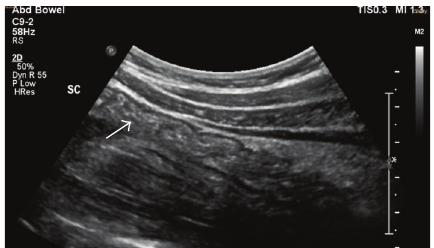
Figure 2: Normal sigmoid colon with normal haustral folds (white